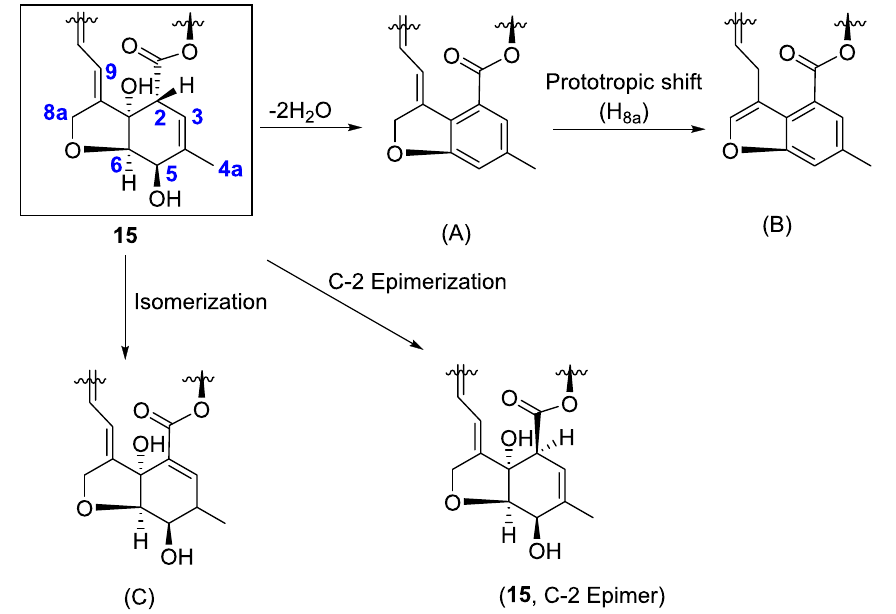
Figure 7. Possible chemical transformations of the oxahydrindene unit of 15 .